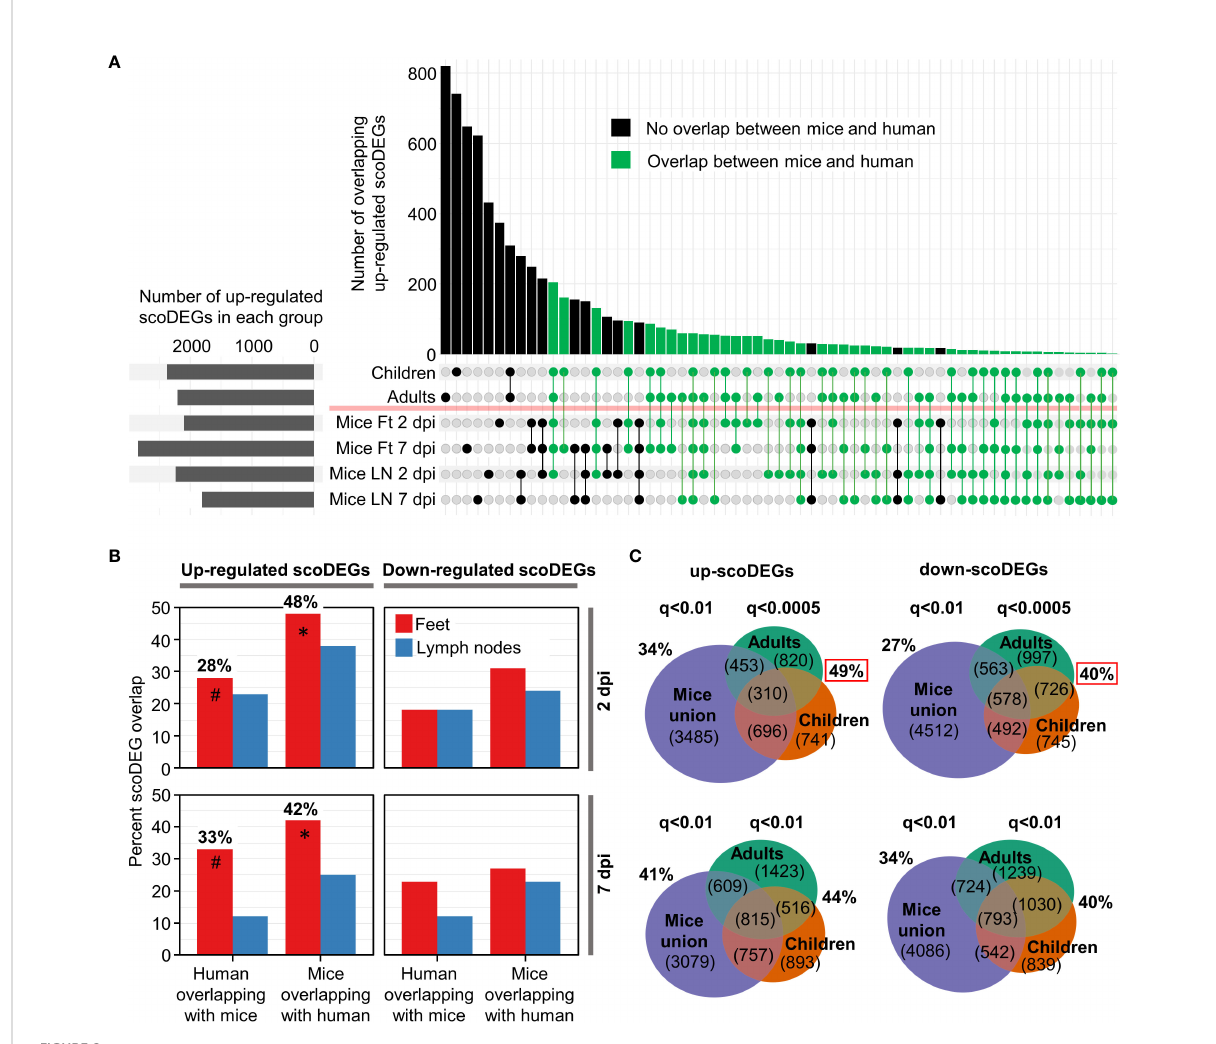
FIGURE 2 ScoDEG overlaps. (A) Upset plot of overlaps of upregulated scoDEGs (from Figure 1D). The overlap between the union scoDEGs (scoDEGs from all mouse groups) and human adults and children. (B) The percent overlap between scoDEGs for all groups. Corresponding Euler diagrams in Figure S4. * Highest overlaps, percent of up-regulated scoDEGs identi fi ed in Mice Ft 2 and 7 dpi that were also identi fi ed in human groups. # For the same groups, but the percentage of up-regulated scoDEGs identi fi ed in humans that were also identi fi ed in Mice Ft 2 and 7 dpi. (C) Top two Euler diagrams; scoDEG overlaps using the FDR (q) cutoffs described in Figure 1D, but where all scoDEGs from all mouse groups are concatenated (union scoDEGs). Red boxes; overlap of scoDEGs identi fi ed in humans that were also identi fi ed in any mouse group. Bottom two Euler diagrams; same as above except using a cutoff of q<0.01 for scoDEG list generation for all